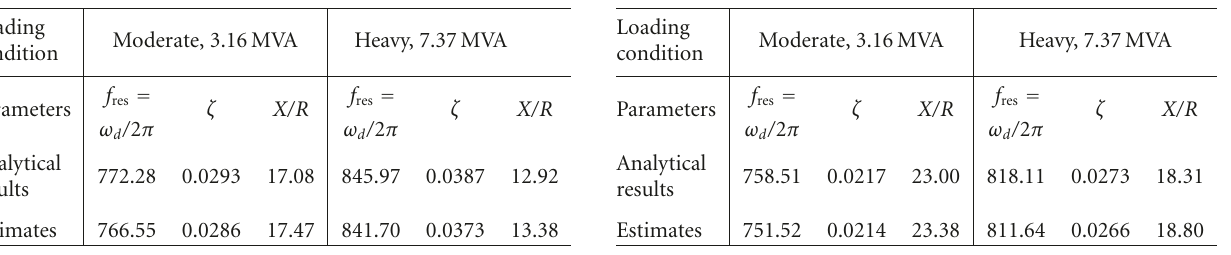
Table 2: Estimation results when load power factor is 0.95. Table 3: Estimation results when load power factor is